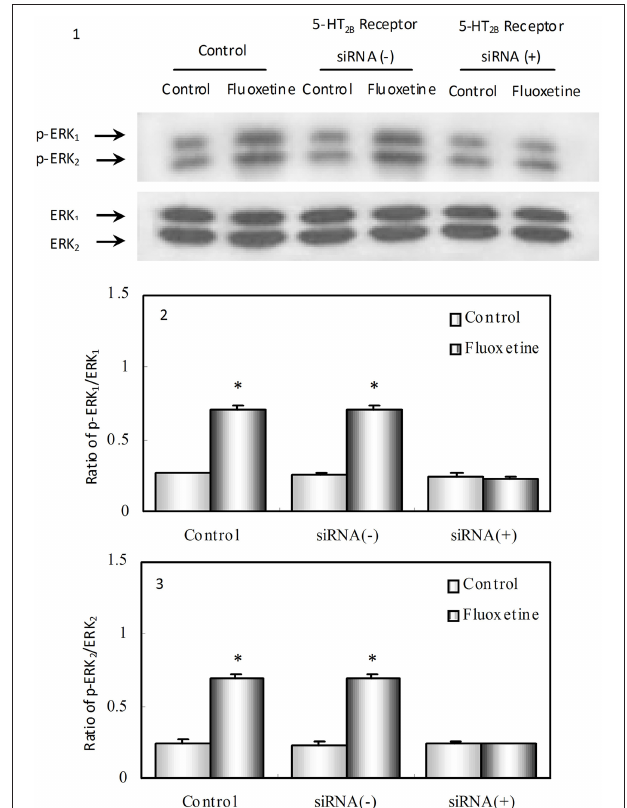
FIGURE 1 | Phosphorylation of ERK 1 / 2 , a known target of 5-HT 2B receptor stimulation in astrocytes. After treatment with phosphate-buffered saline, PBS (Control), transfection solution without siRNA (siRNA ( − )) or siRNA specific to 5-HT 2B receptor [siRNA ( + )], culturing of well differentiated astrocytes (at least 3 weeks in culture and treated with dibutyryl cAMP [dBcAMP]), was continued for another week. Since 5-HT 2B receptor expression in the cultures had been normal until the exposure to siRNA the result indicates an effect on mature astrocytes. This contrasts the non-conditional gene knockouts of intact mice used by Diaz et al. (2012), where effects during development cannot be ruled out. For the phosphorylation experiments, the cells were incubated for 20min in serum-free medium in the absence of any drug (Control) or in the presence of 10 µ M fluoxetine. (1) Immunoblot showing gene expression of phosphorylated and non-phosphorylated ERK 1 and 2 (p-ERK 1 and ERK 1 and p-ERK 2 and ERK 2 ) from representative experiments. Similar results were obtained in three independent experiments. Average ERK phosphorylation was quantitated as ratios between p-ERK 1 and ERK 1 (2) and between p-ERK 2 and ERK 2 (3). SEM values are indicated by vertical bars. * Indicates statistically